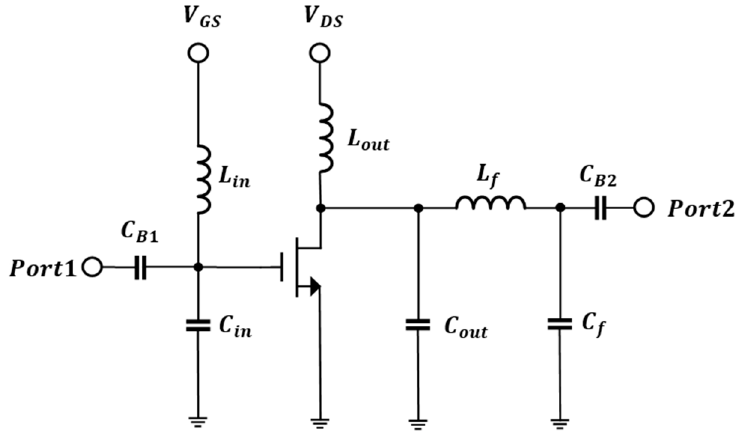
Figure 1. Schematic of a class-E power amplifier using an L-type matching network at the output stage.